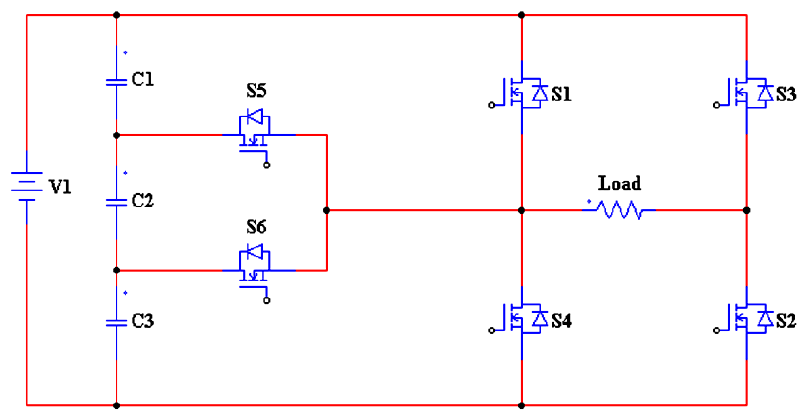
Figure 16. Circuit of hybrid cell technology for MLI.